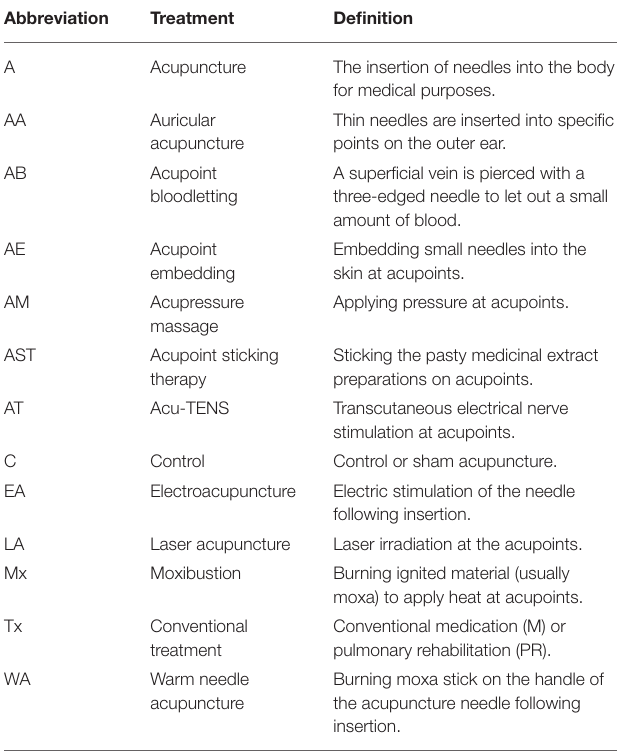
TABLE 1 | Definitions of the acupuncture point stimulation treatments